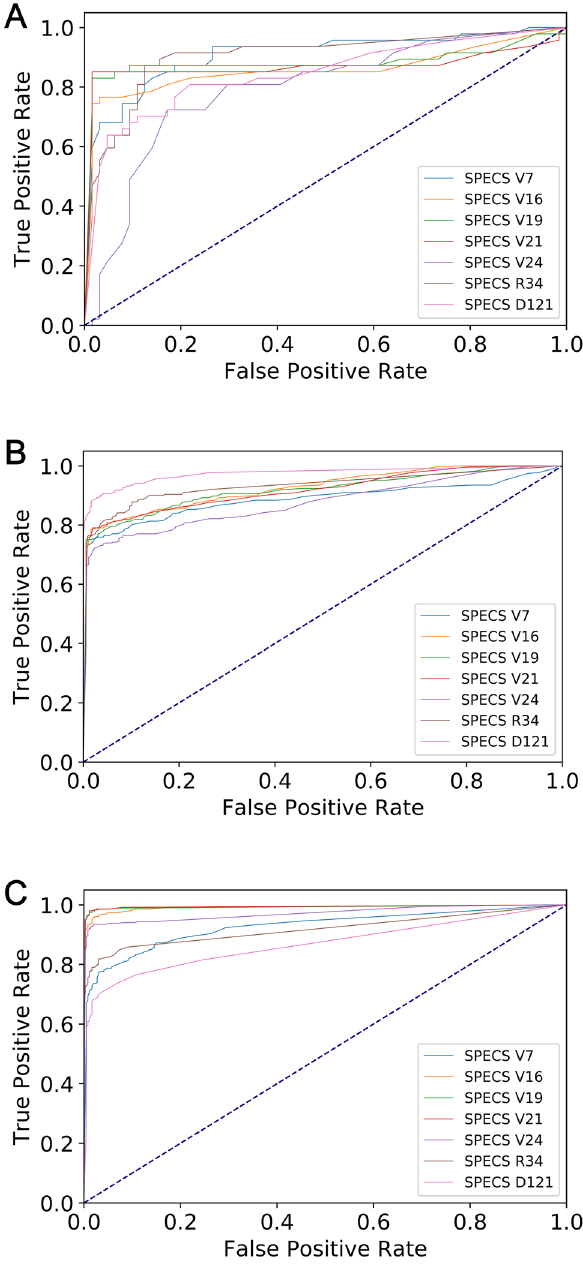
Figure 9. The ROC curves of the classifiers on test samples in different datasets. ( a ) Dataset D 1 ; ( b ) Dataset D 2 ; and ( c ) Dataset D 3 .